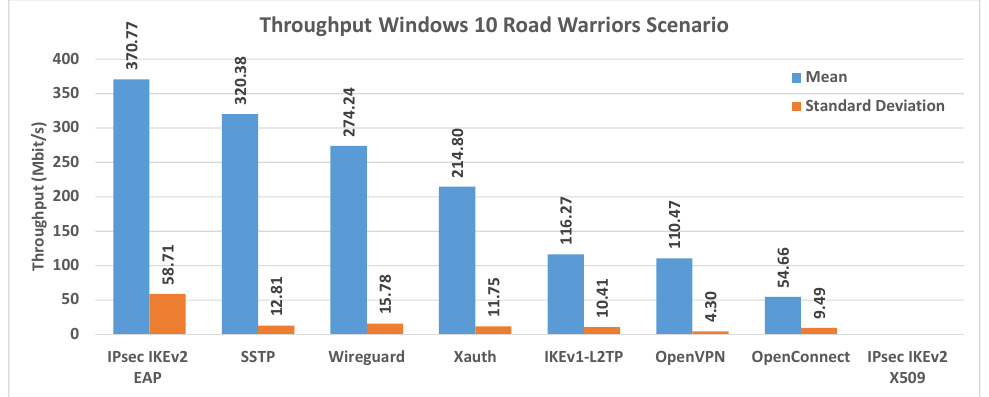
Figure 20. Comparison of Throughputs on Windows 10 in all scenarios.